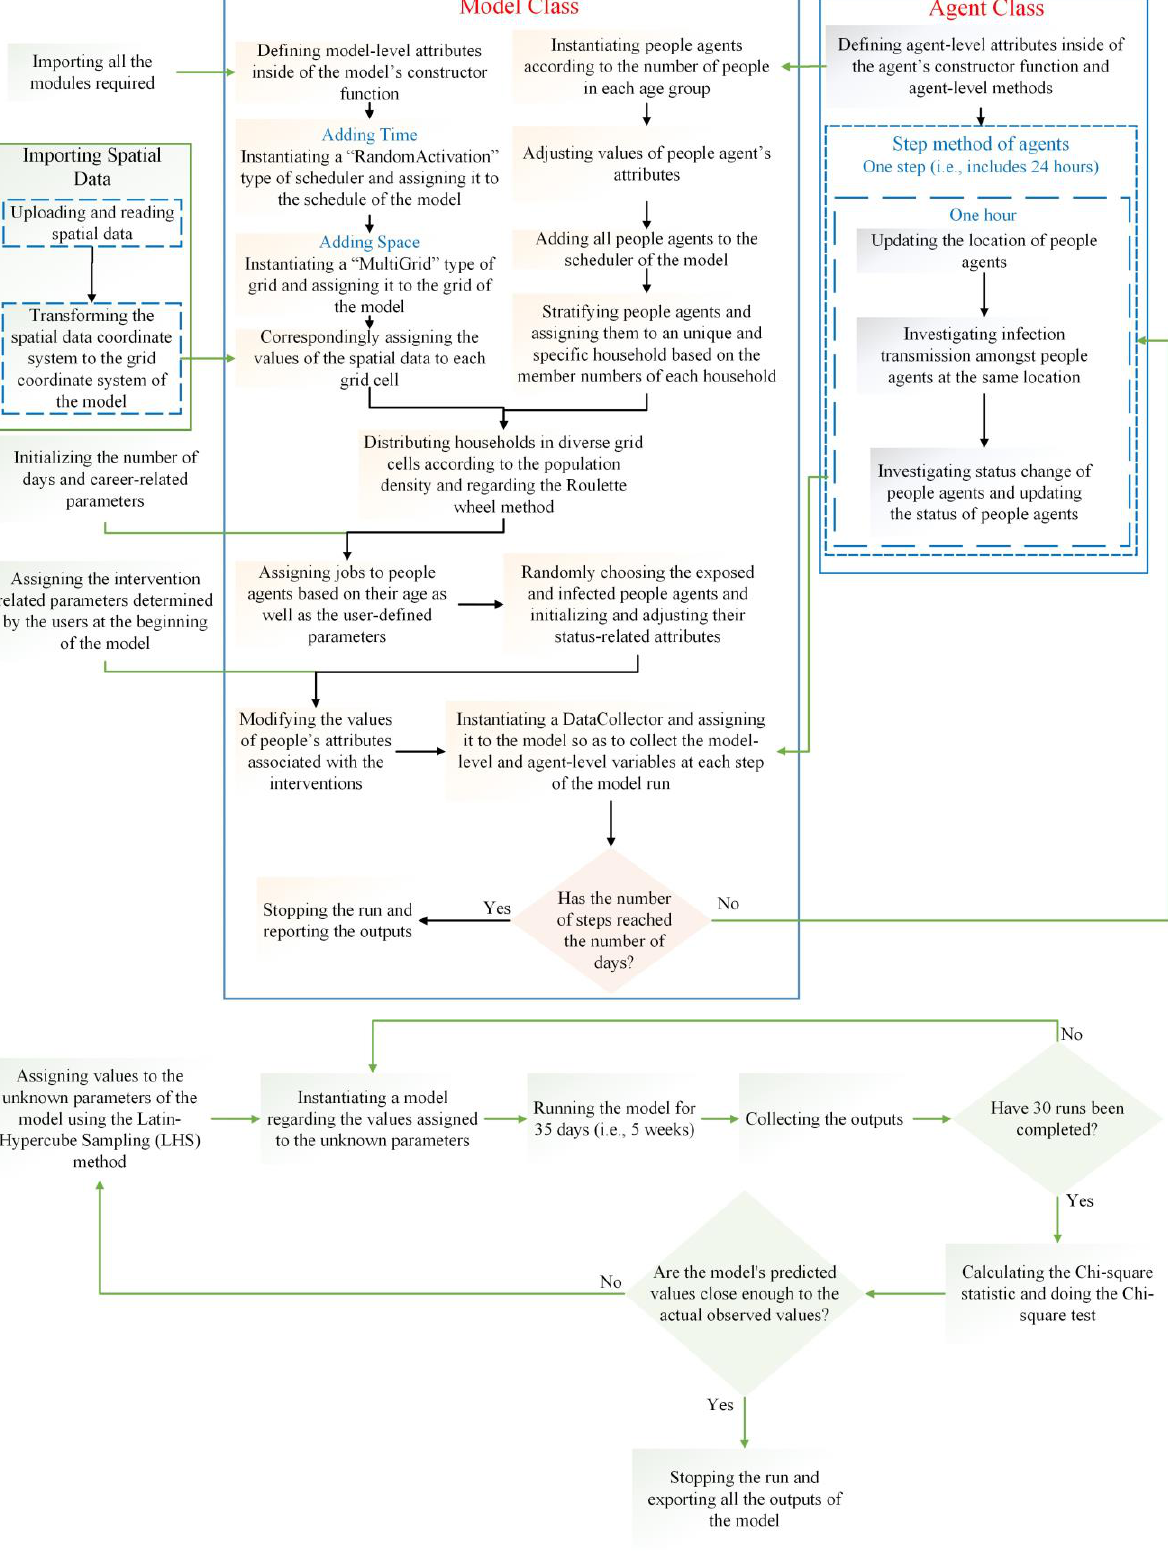
All parameters used in calculation of infection-transmission probability.